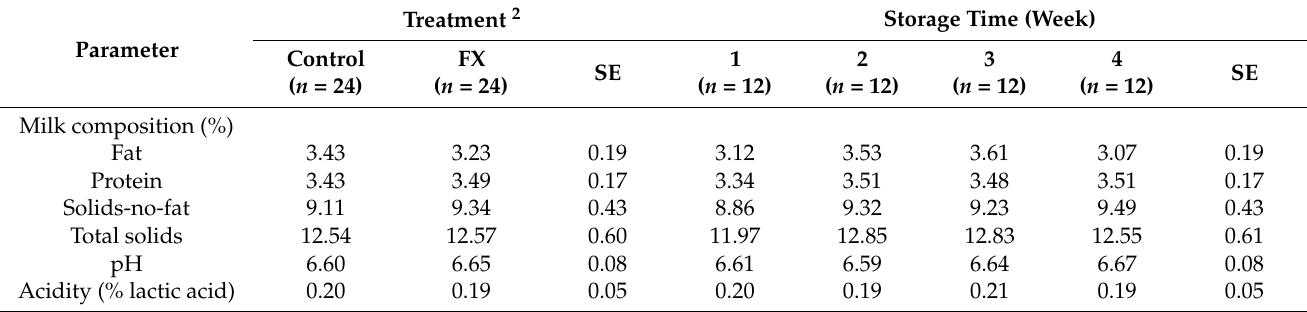
Table 4. Effect of fucoxanthin supplementation on goat whole milk composition, pH, and acidity 1 during storage (4 ◦ C). Treatment 2 Storage Time (Week) Parameter